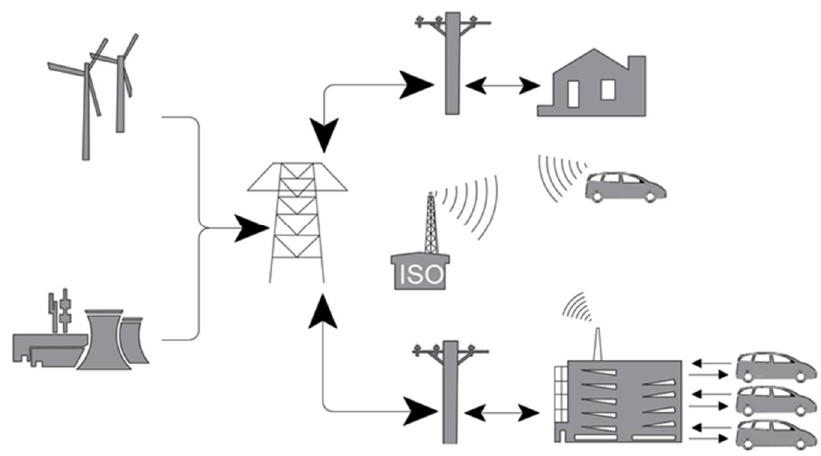
Figure 5. Electrical distribution for EV with wireless control of the charging